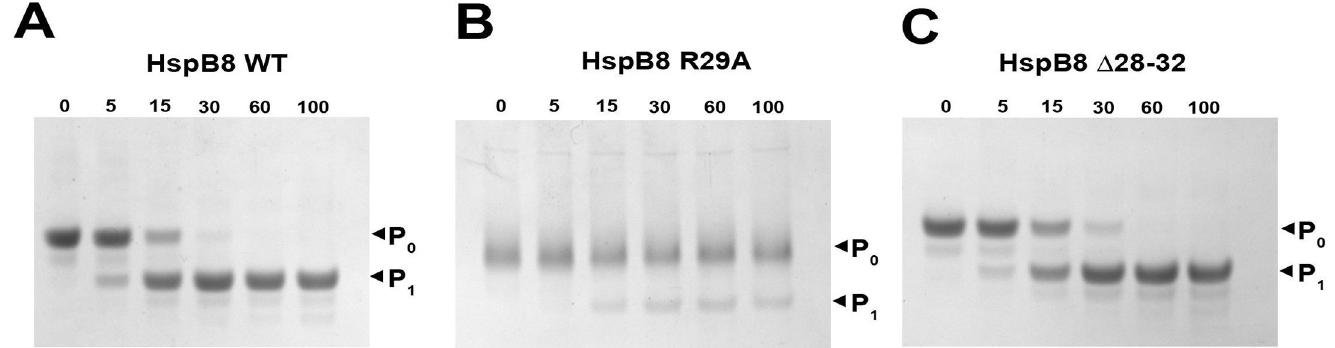
Fig 5. Phosphorylation of HspB8 and its mutants by cAMP-dependent protein kinase. Urea gel-electrophoresis of HspB8 WT (A), and its R29A (B) and Δ 28–32 (C) mutants in the course of phosphorylation. Incubation time (min) is indicated above each lane. P 0 represents a band of protein with no phosphate groups, P 1 represents a band of protein with one phosphate group.